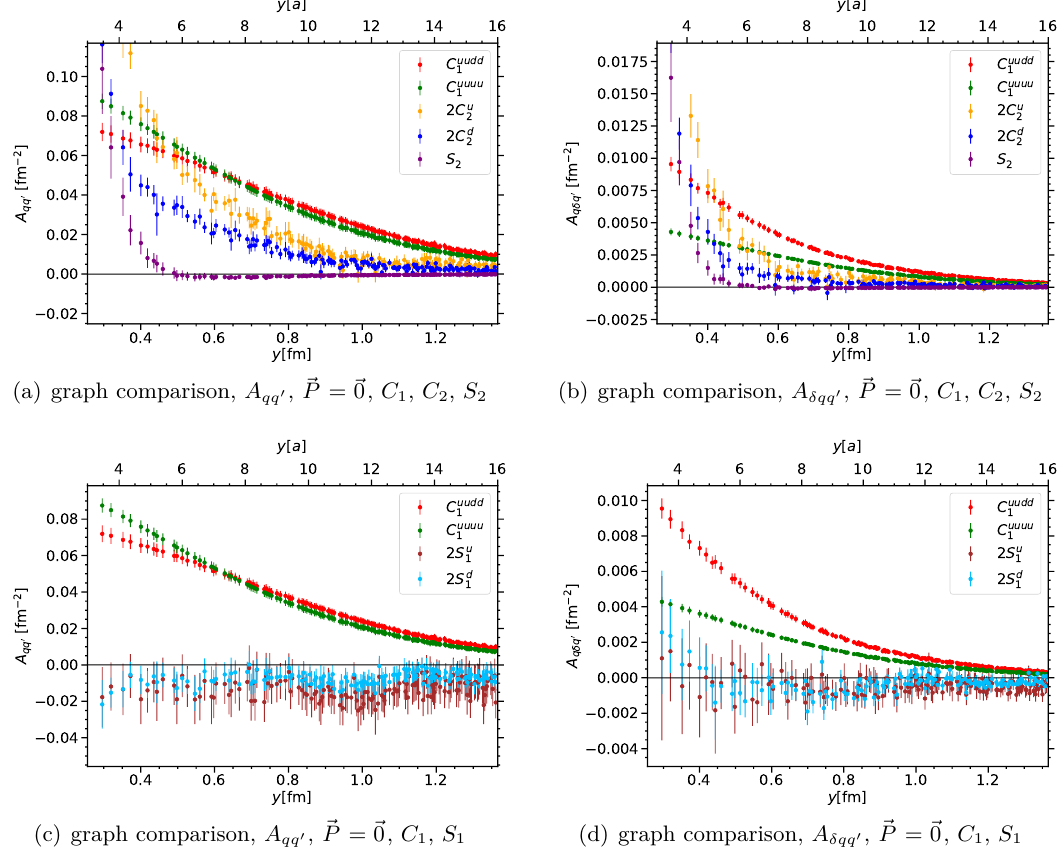
Figure 11 . Comparison between the contributions of each Wick contraction to the twist-two functions for ~P = ~ 0 and A S 2 , whereas in (c,d) we compare the data for C 1 and S 1